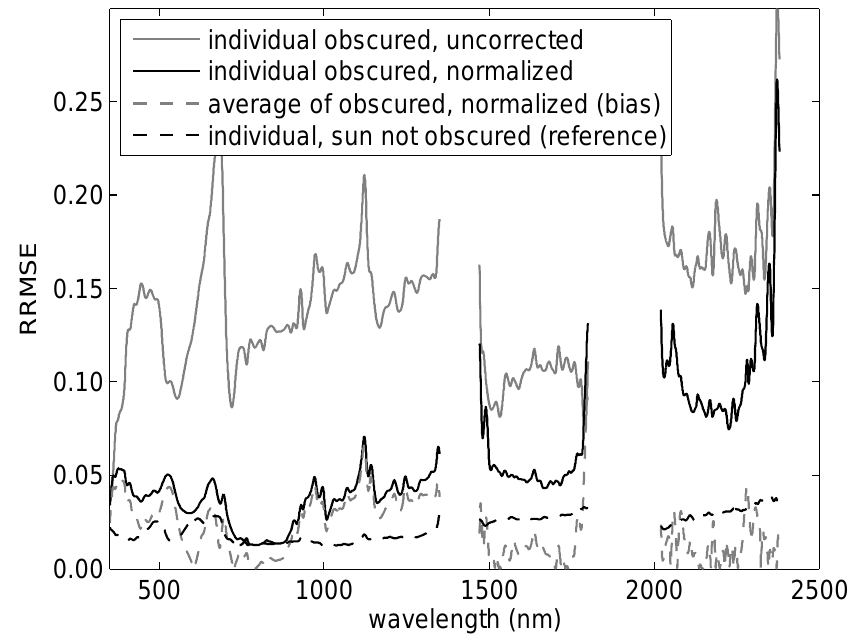
Figure 10. Relative error in reflectance (RRMSE) of measurements under obscured condi- tions using unobscured measurements as a